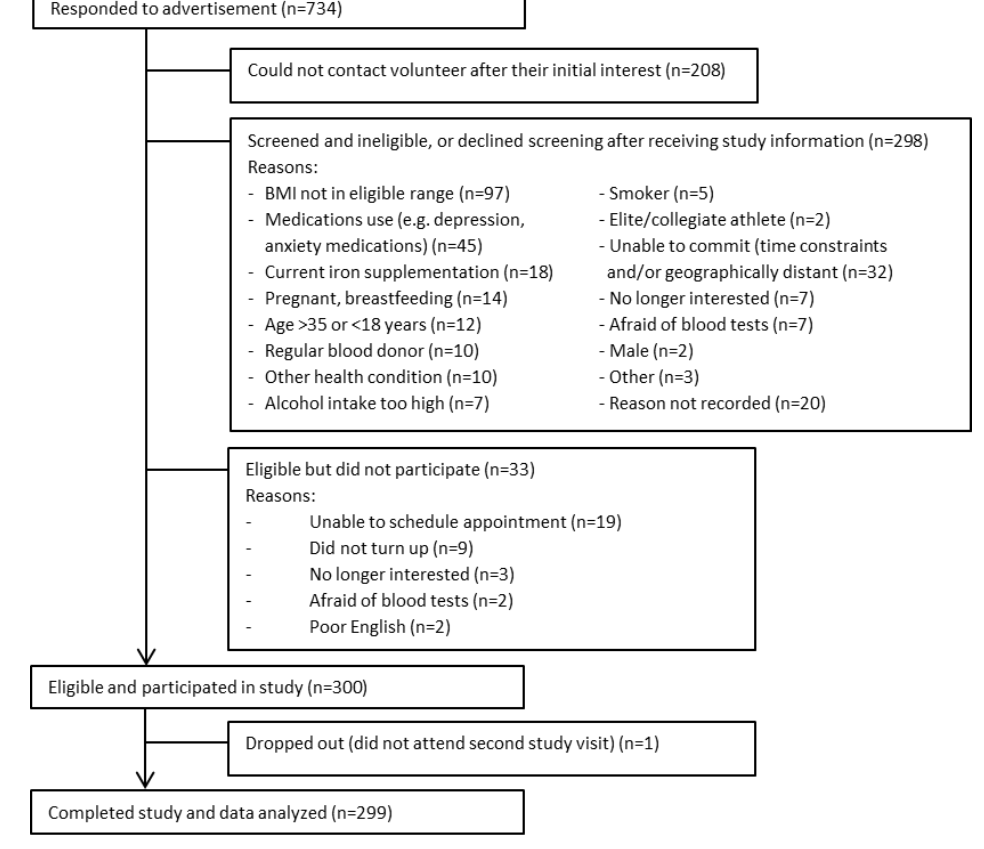
Figure 1. Participant recruitment and study participant flow chart.